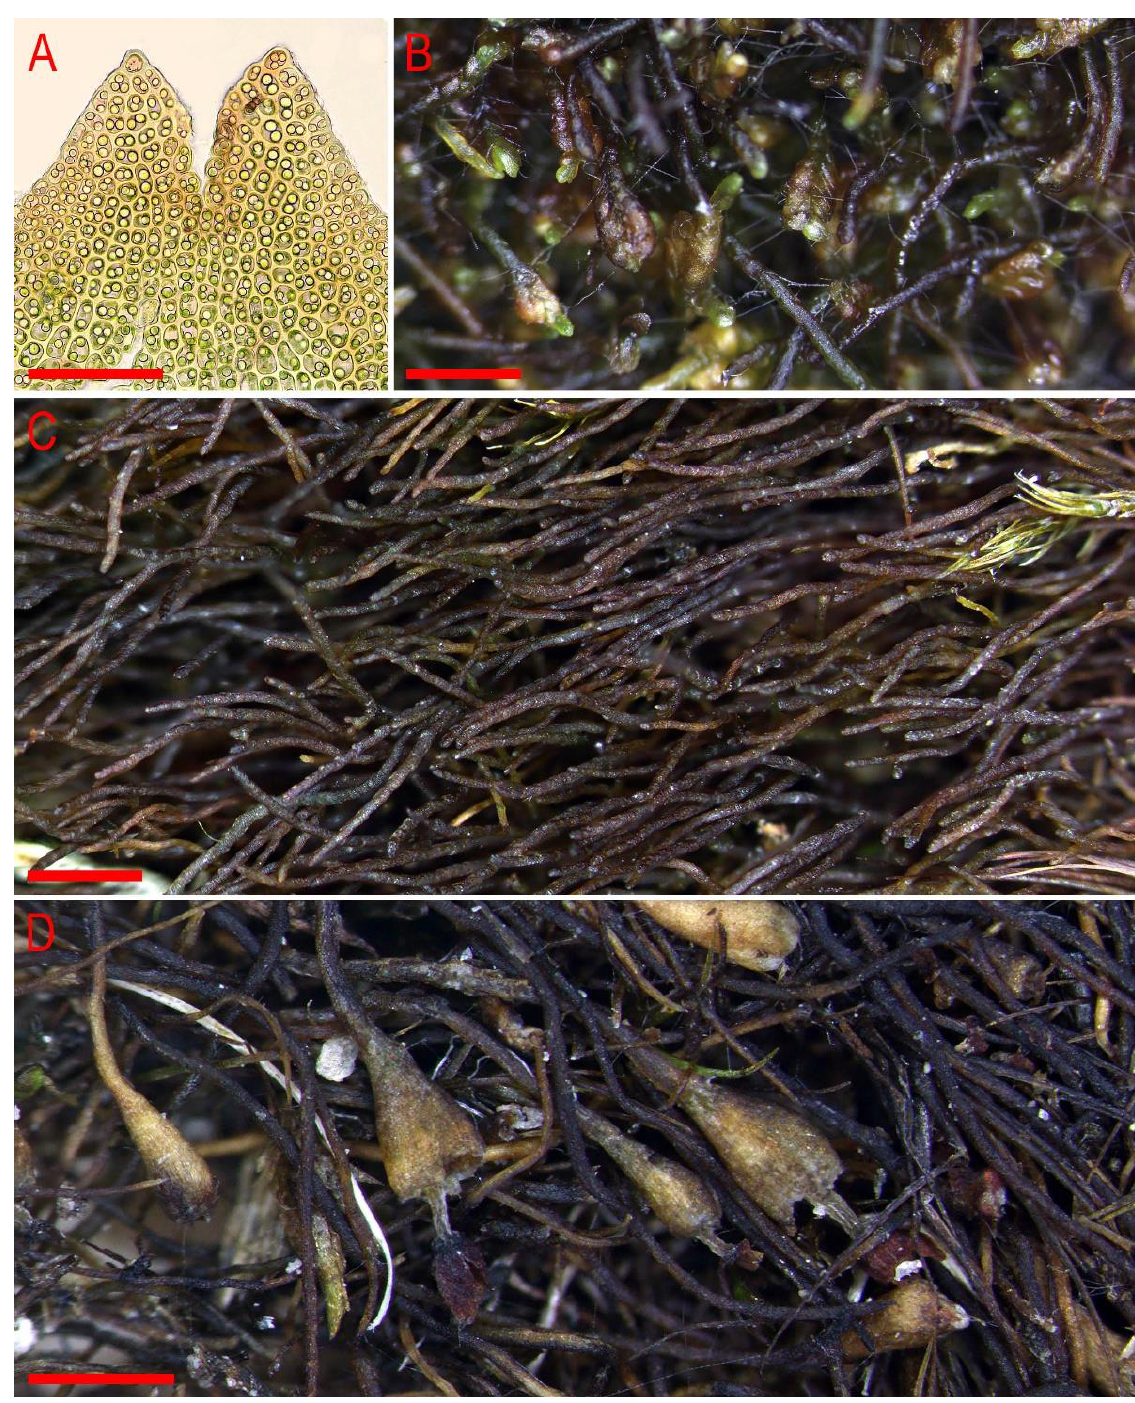
Figure 10. Marsupella stoloniformis N. Kitag.: ( A ) upper part of female bract; ( B ) mat, male plants, moist condition; ( C ) mat, sterile plants, moist condition; ( D ) mat, plants with perianths and open sporophytes, dry condition. Scale: 50 µm for ( A ); 1 mm for ( B , C ); 500 µm for ( D ). ( A ) from V-11-28-17 (VBGI); ( B ) from V-11-24-17 (VBGI); ( C ) from V-11-12-19 (VBGI); ( D ) from V-10-14-19 (VBGI). 3. Leaves always divided by semi-crescentic sinus with lobes acute . . . M.